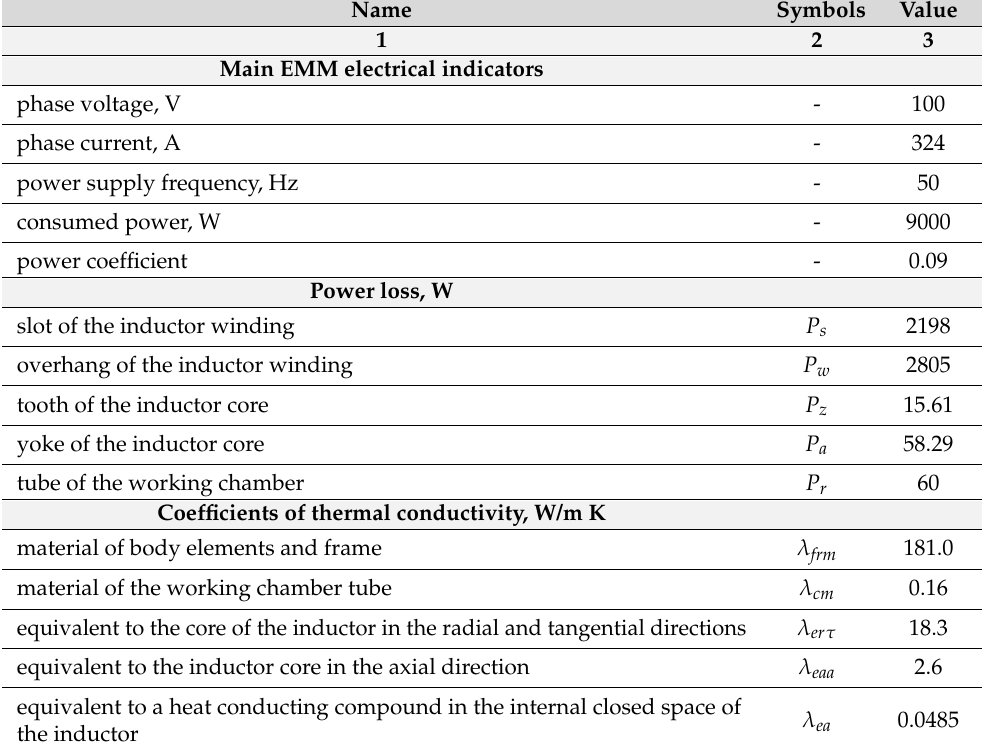
Table 1. Input information for thermal